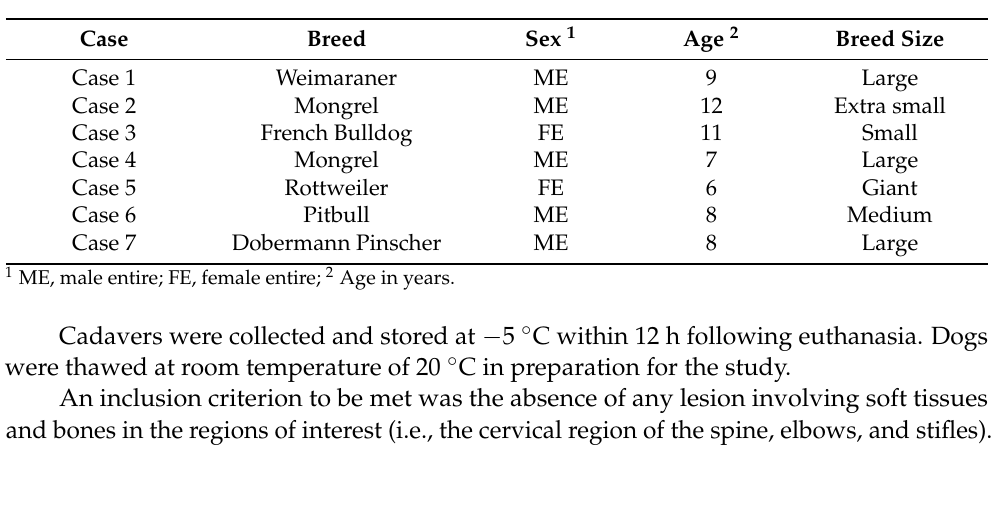
Table 1. Signalment of the 7